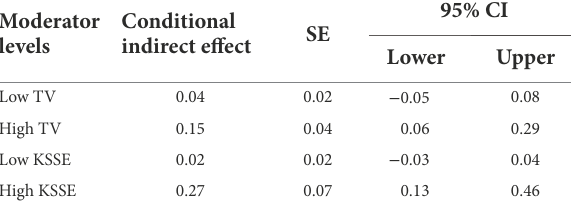
TABLE 5 Moderated mediation results for KSB across levels of TV and